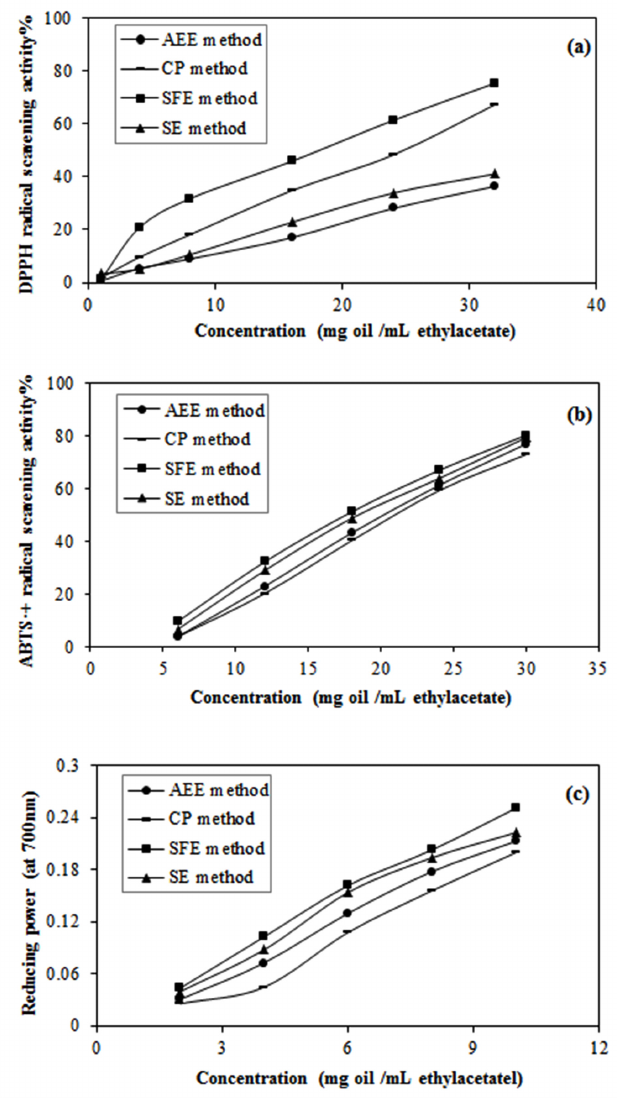
Fig. 3: Investigation of antioxidant activity of A. pedunculatus seed oil, ob- tained by different extraction methods, using the following in vitro assays: (a) DPPH radical scavenging assay, (b) ABTS radical sca- venging assay, and (c) reducing power